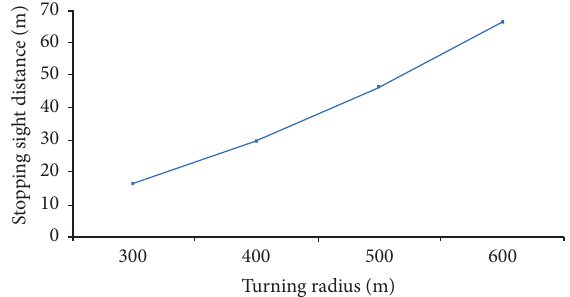
Figure 6: Relationship between curve radius and curve stopping sight distance.